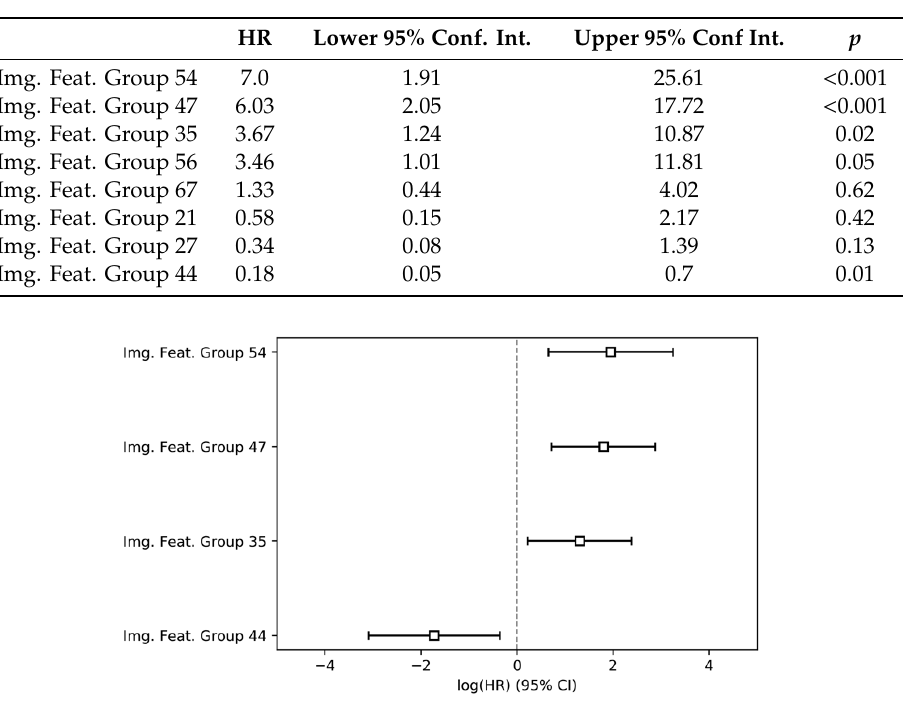
Figure 3. Hazard ratios and 95% confidence intervals of parameter group 3 (image-derived parameters).